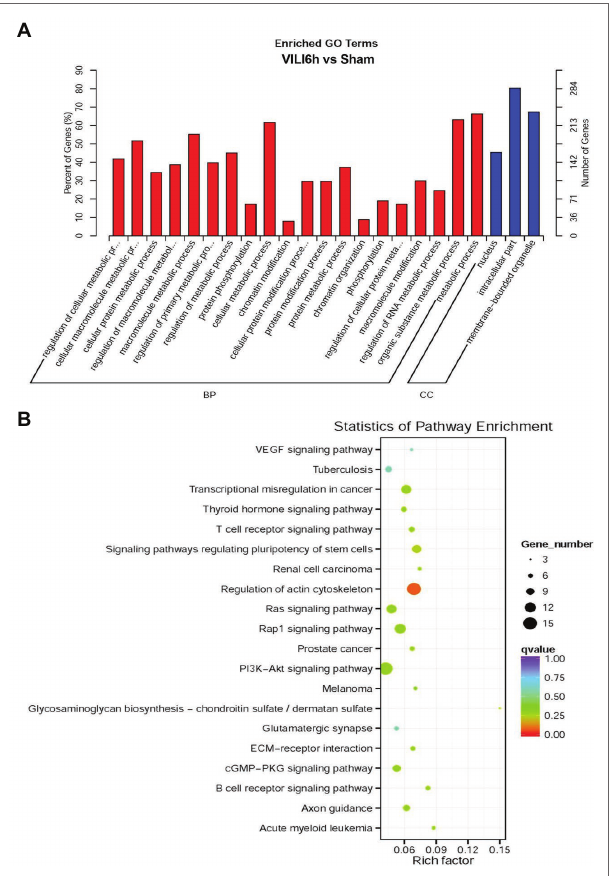
TABLE 2 | The primer list was used for real-time quantitative PCR.